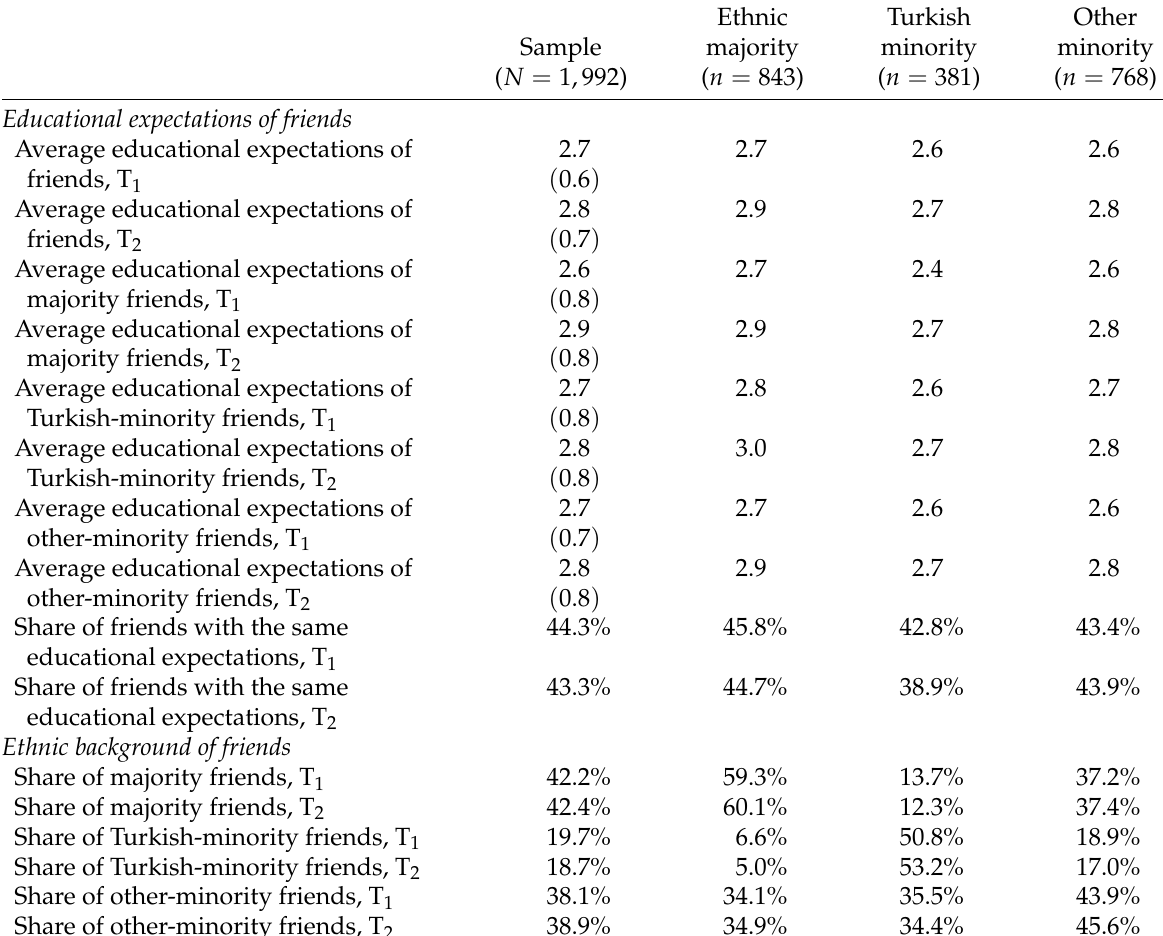
Table 2: Composition of social networks concerning educational expectations and the ethnic background of friends.